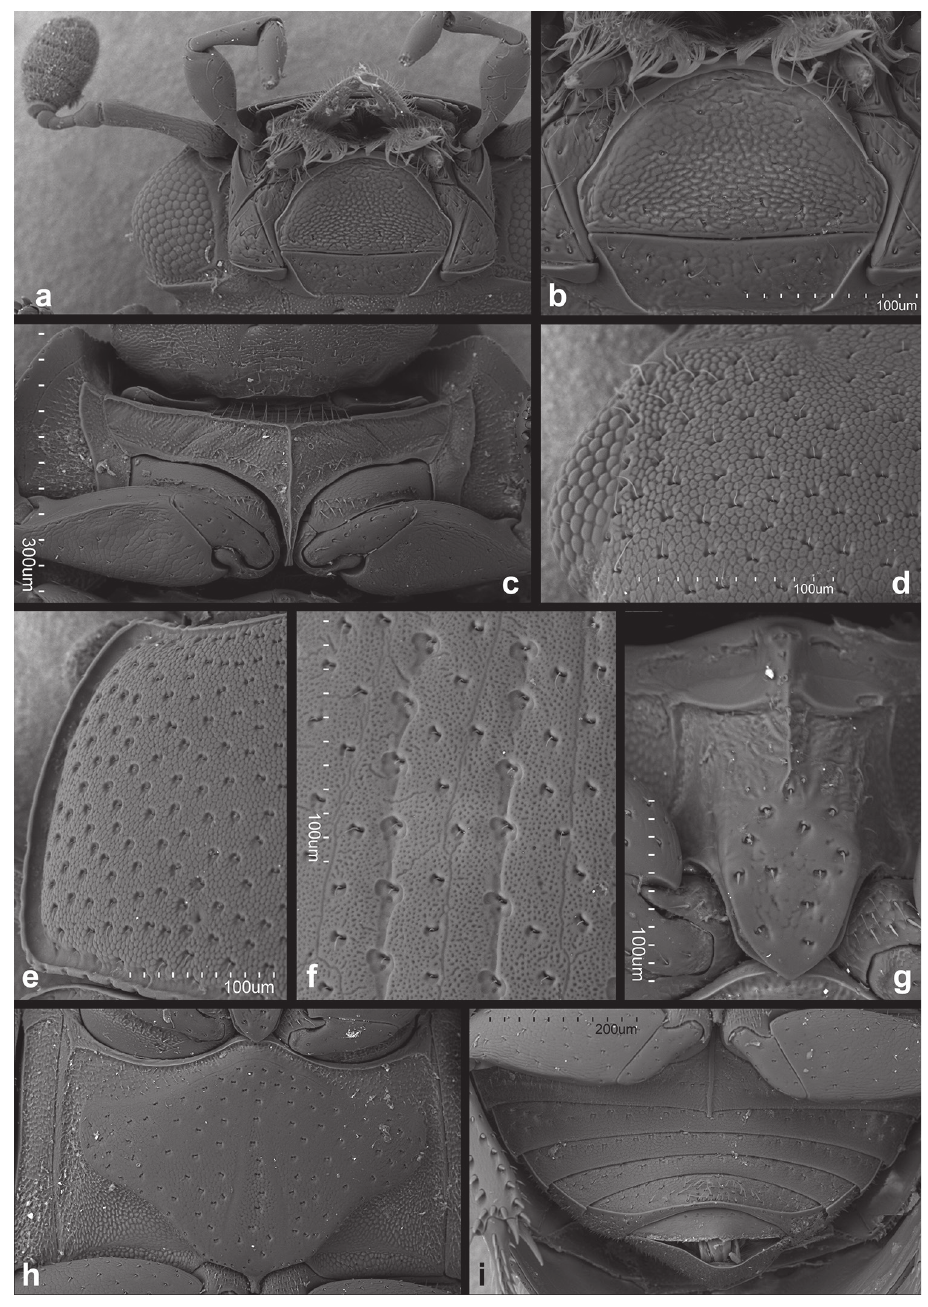
Figure 4. Evanesternum pulsatum (d’Orchymont) a ventral view of head b labium c prosternum d detail of head surface e detail of pronotal surface and lateral margin f detail of elytral surface g mesoventral plate h metaventrite i ventral view of